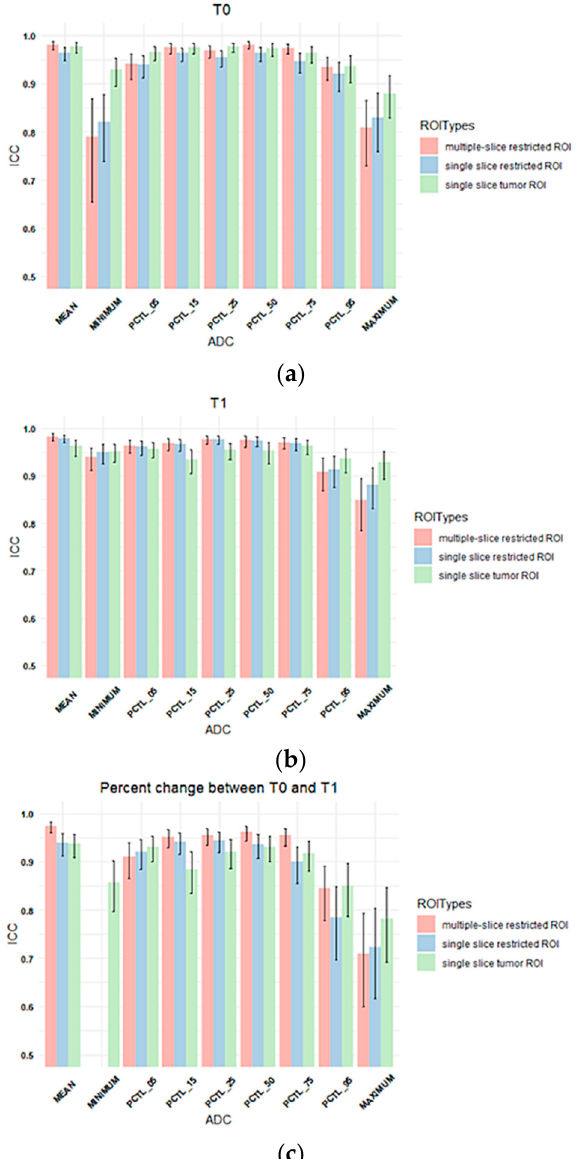
Figure 3. Column plots showing the ICC values of tumor ADC histogram parameters between Reader 1 and Reader 2 for ( a ) T0, ( b ) T1, and ( c ) percentage change between T0 and T1. The x-axis lists mean ADC and histogram parameters of ADC values within the ROI (minimum, 5th percentile, 15th percentile, 25th percentile, 50th percentile, 75th percentile, 95th percentile, maximum), and the y-axis shows the ICC values. Colors represent ROI types. Multiple-slice and single-slice restricted ROI were shown as blank for minimum ADC in ( c ) because both ICCs were below 0.5. (pink: multiple-slice restricted ROI, blue: single-slice restricted ROI, green: single-slice tumor ROI). Error bar is 95% CI. PCTL = percentile.